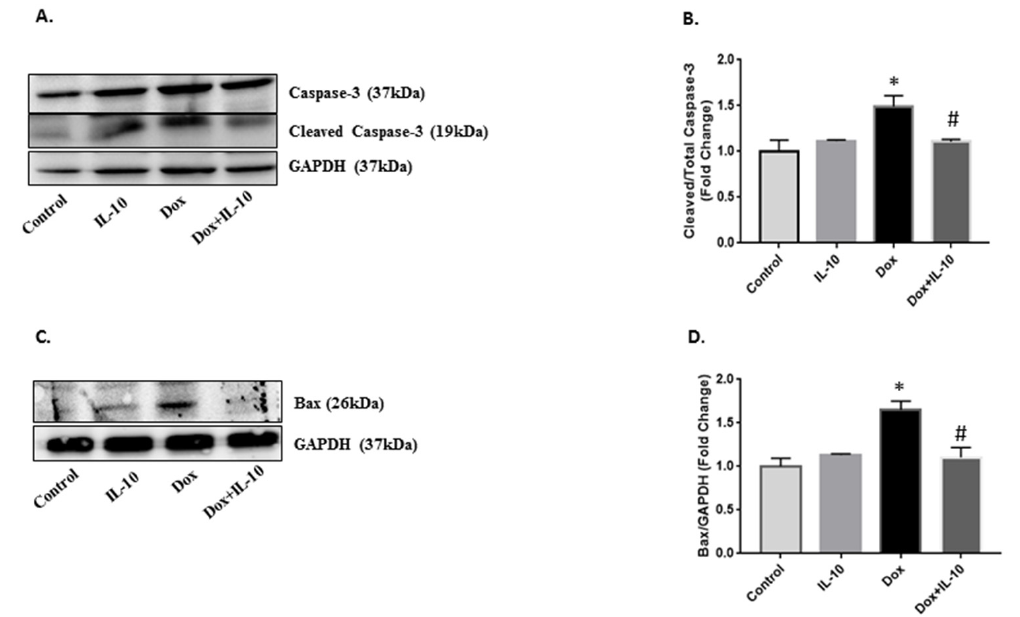
Figure 7. Effects of IL-10 on mitochondrial apoptotic proteins. Expression of apoptosis-inducing proteins in isolated cardiomyocytes treated with Dox (5.43 µg/mL) in the presence or absence of IL-10 (10 ng/mL) for 24 h. ( A ) Western blot of cleaved and total caspase-3 using caspase-3 antibody (1:1000); GAPDH is shown as a loading control. ( B ) Densitometric analysis of cleaved caspa- se-3/total caspase-3. ( C ) Western blots of Bax protein using Bax antibody (1:1000). ( D ) Densitomet- ric analysis of Bax using GAPDH as a loading control. Data are means +/ − SE from 5 individual experiments. * p < 0.05 vs. control, IL-10; # p < 0.05 vs. Dox.